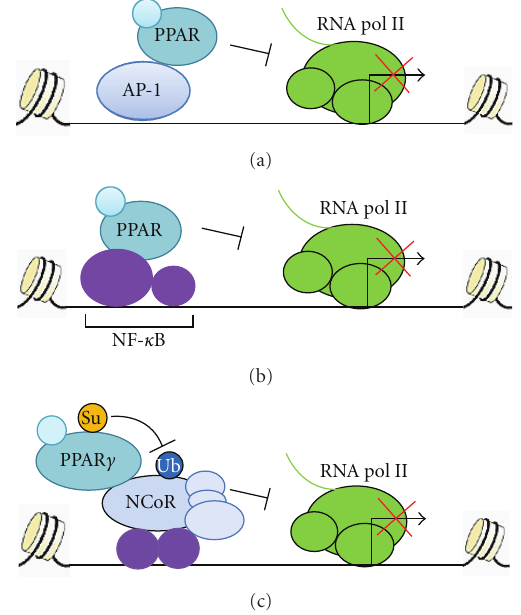
Figure 3: Molecular mechanisms of PPAR transrepression path- ways. (a-b) Ligand-activated PPAR ( α or γ ) inhibits the activities of AP-1 and NF- κ B through direct interactions with the c-Jun subunit and the p65 subunit, respectively. (c) On ligand binding, PPAR γ is sumoylated and blocks ubiquitin-dependent proteasomal degradation of the NCoR corepressor complexes at NF- κ B-binding sites. The presence of the corepressor complexes prevents the recruitment of transcriptionally active NF- κ B, leading to inhibition of inflammatory gene